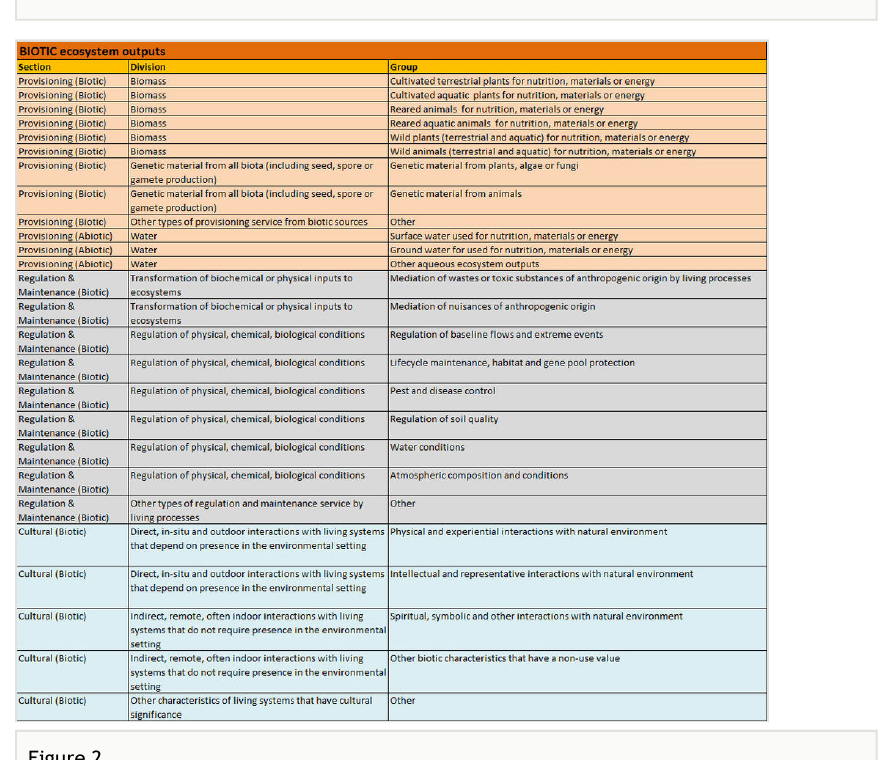
Figure 2. Overview of revised structure of CICES (V5.1) for biotic ecosystem services (upper three levels in the classi fi cation